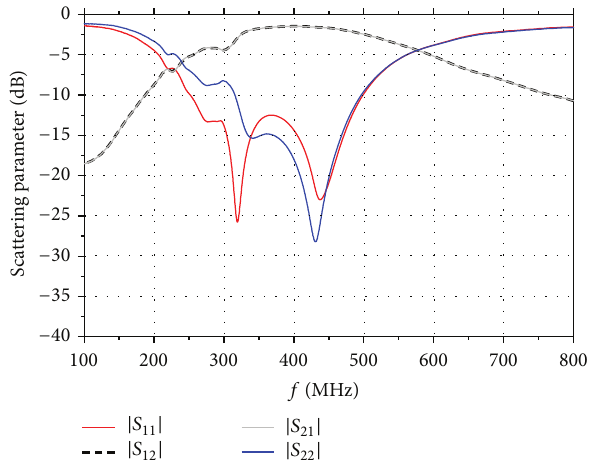
Figure 7: 𝑆 -parameters measured by using the experimental config- uration shown in Figure 6(b).